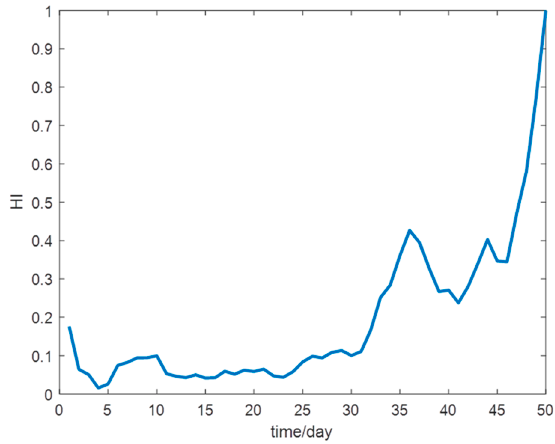
Figure 7. High-speed shaft bearing HI curve.